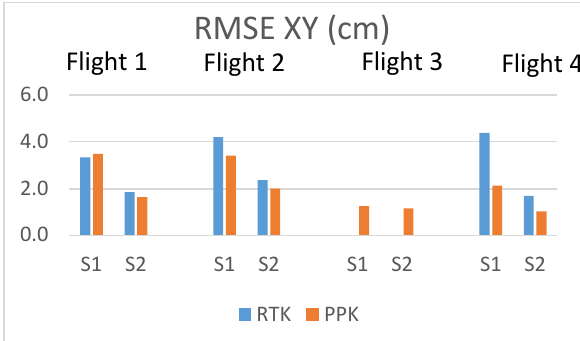
Figure 10. RMSE of the horizontal coordinates in the S1 and S2 Cases for the flight data from RTK and from a PPK solution.